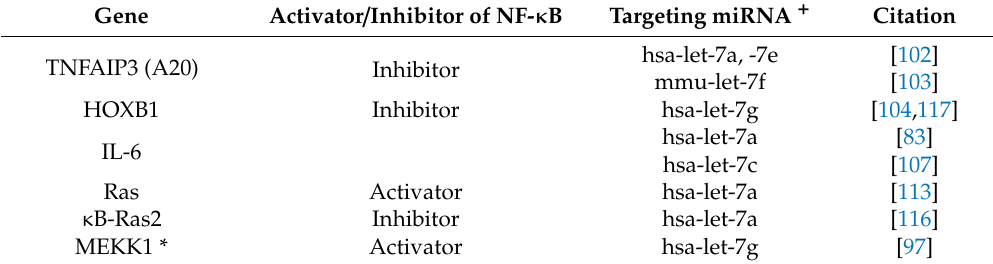
Table 2. Let-7 targeting of regulators of NF- κ B